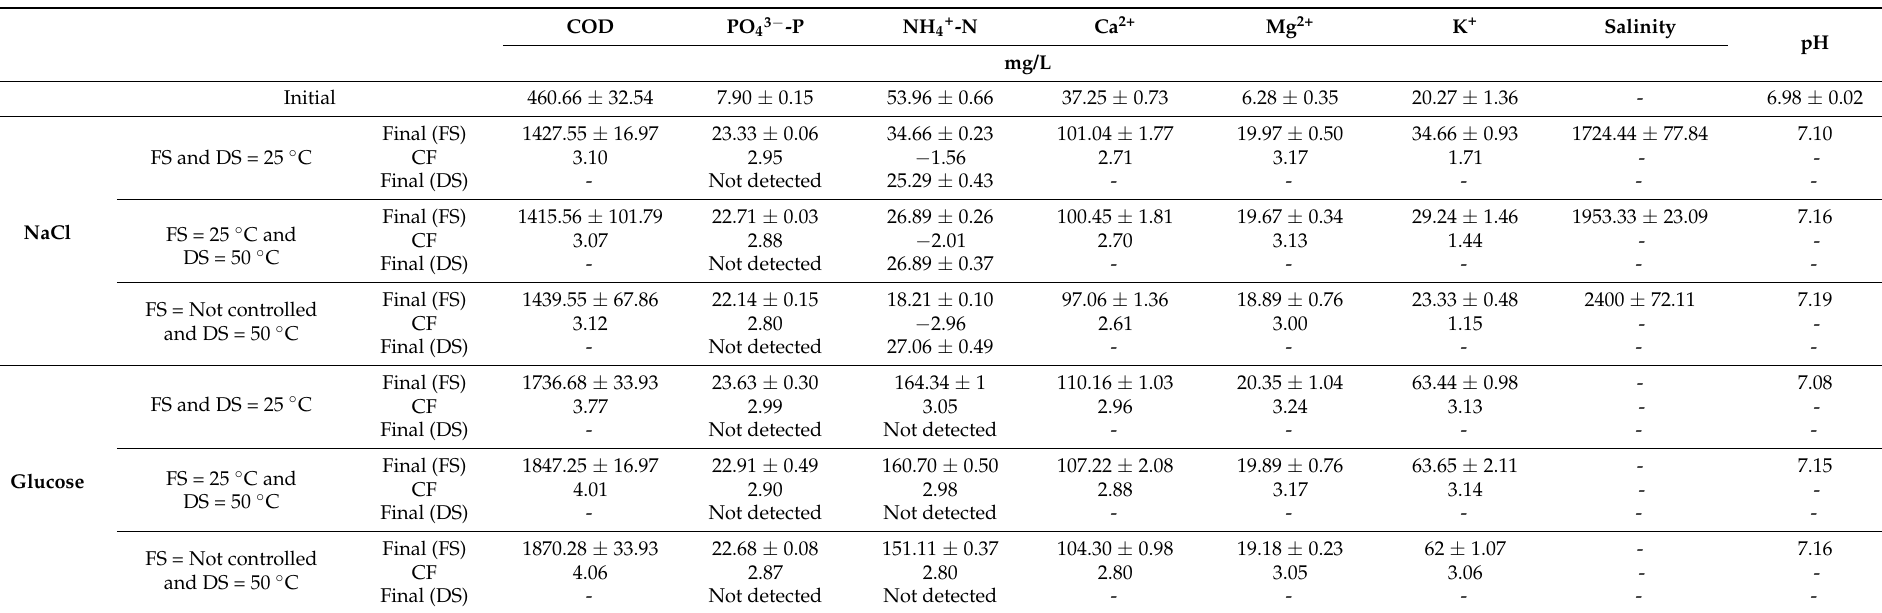
Table 1. Summary of the initial and final concentrations of pollutants in the synthetic municipal wastewater FS with 0.6 M and 1.2 M glucose as the DS, respectively, and the concentration factors of each pollutant at a 70% water recovery rate after the TFC hollow fiber FO membrane filtration at different FS and DS